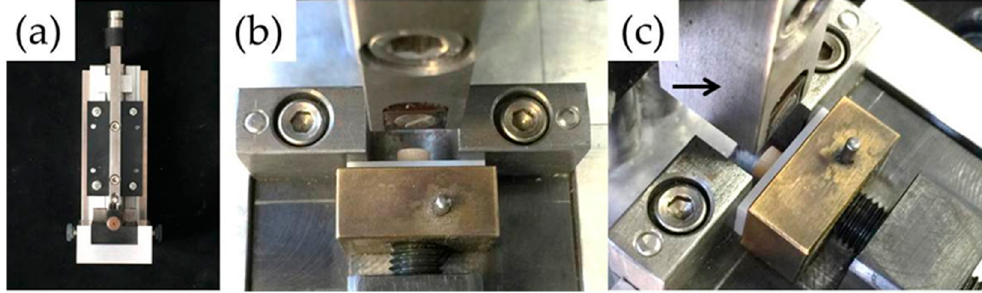
Figure 3. Shear bond strength testing: ( a ) a metal holder with a special designed metal piston; ( b ) fixation of a specimen; and ( c ) during shear bond strength testing.